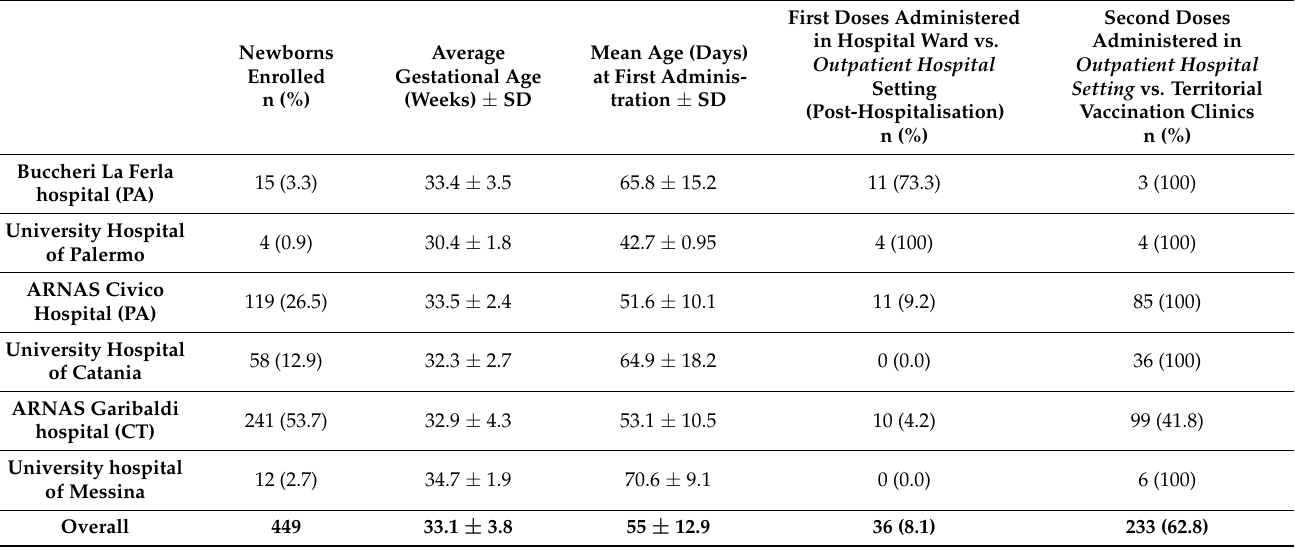
Table 2. Characteristics of preterm newborns vaccinated against RV in the six Sicilian NICUs (neonatal intensive care units) involved in this study (n =